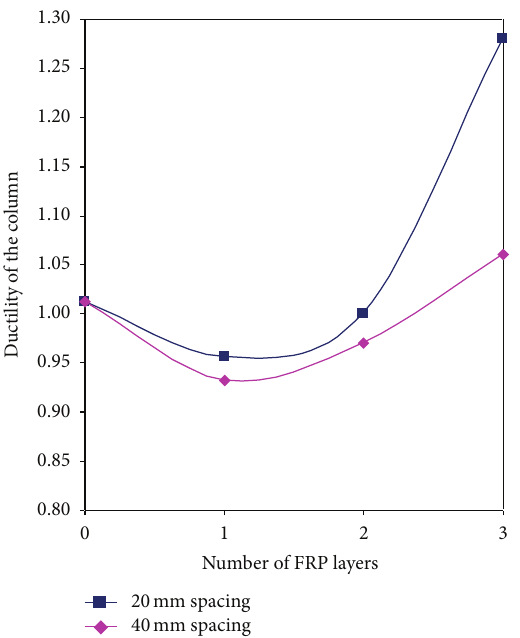
Figure 17: Displacement ductility behaviour of all columns,